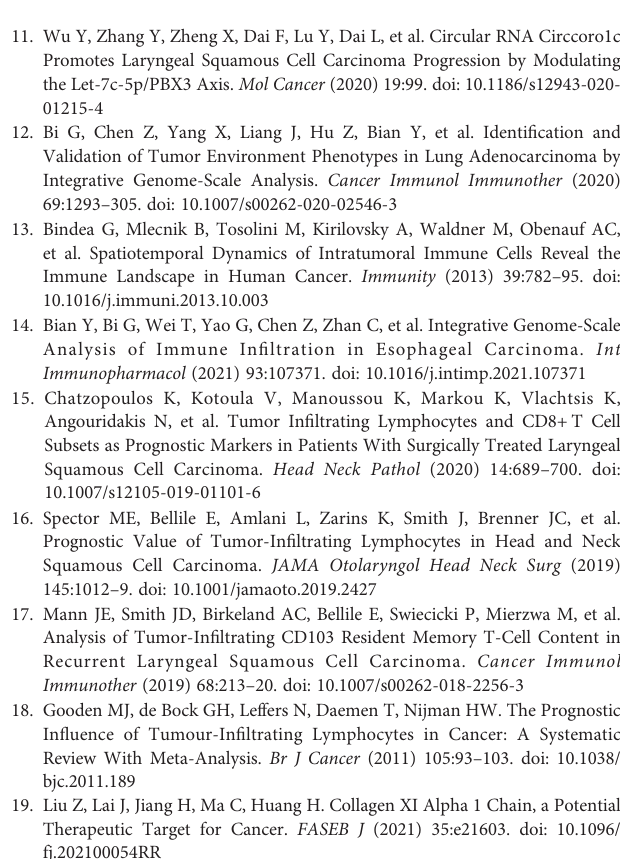
Supplementary Figure 4 | Survival analyses of genes in the